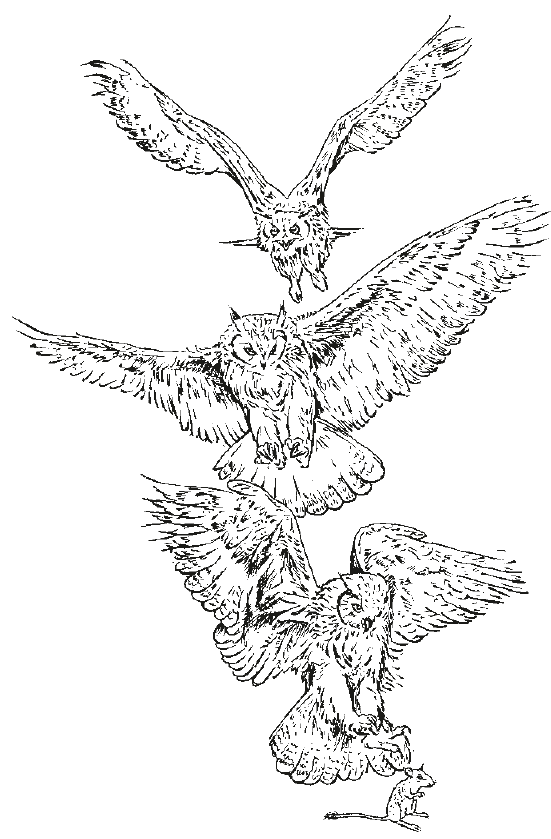
Image 11. Indian Eagle Owl Bubo bengalensis and Indian Gerbille Tatera indica . Drawn using ordinary micro tip pen.